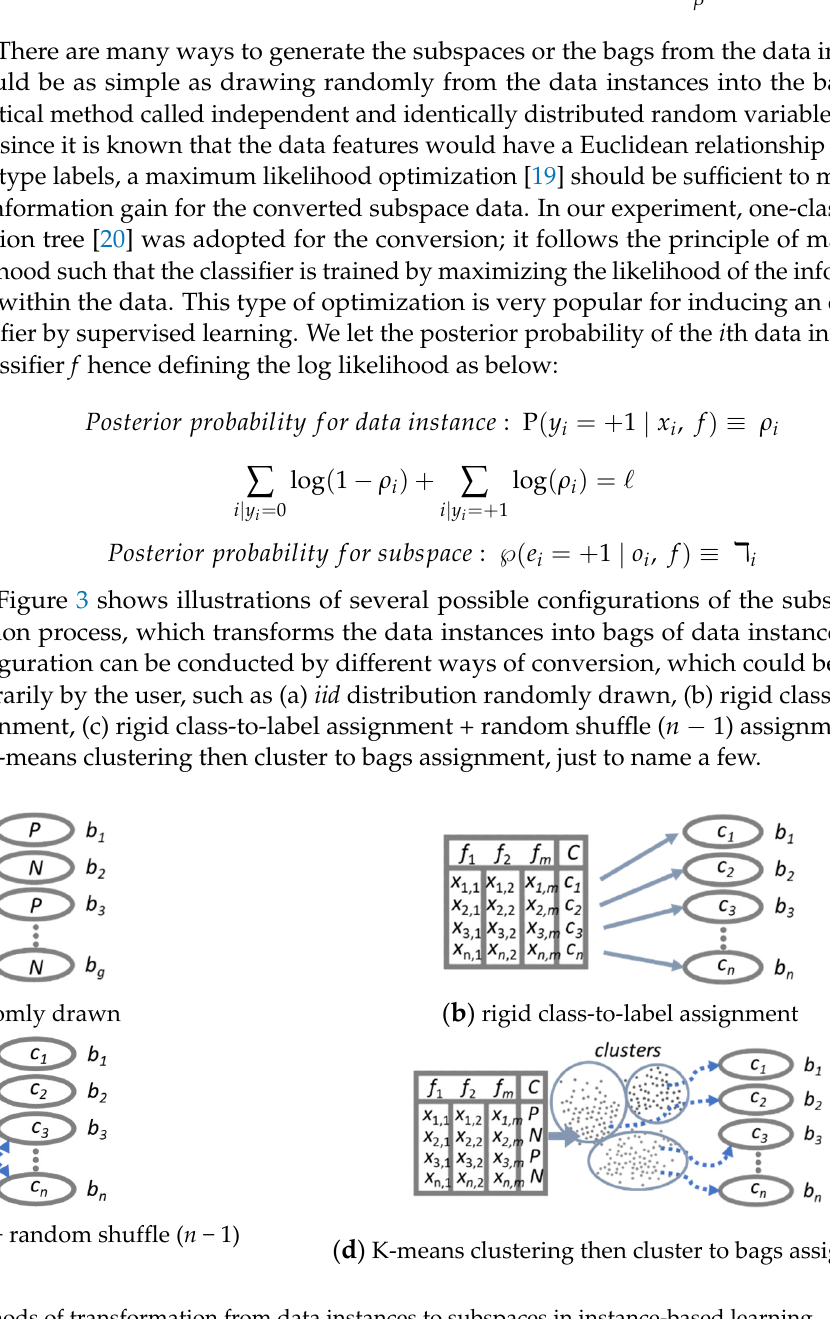
Figure 3. Four possible methods of transformation from data instances to subspaces in instance-based learning.